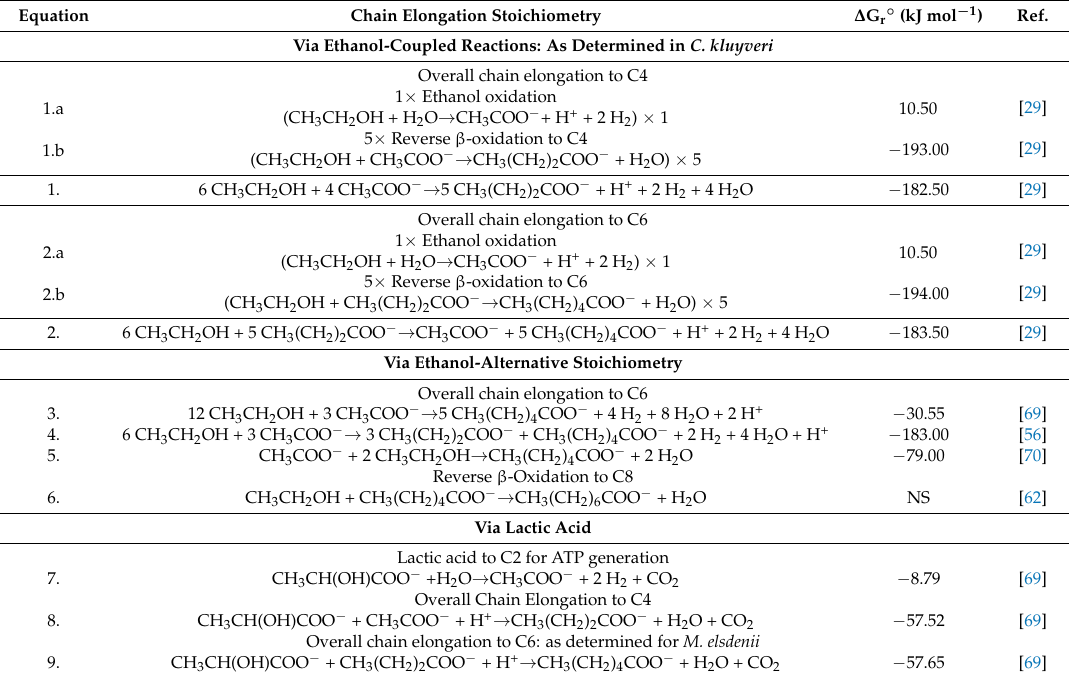
Table 1. Chain elongation reactions via ethanol and lactic acid and thermodynamic information with concentrations and pressures of all components at 1 M or 1 bar, pH 7 at 25 ◦